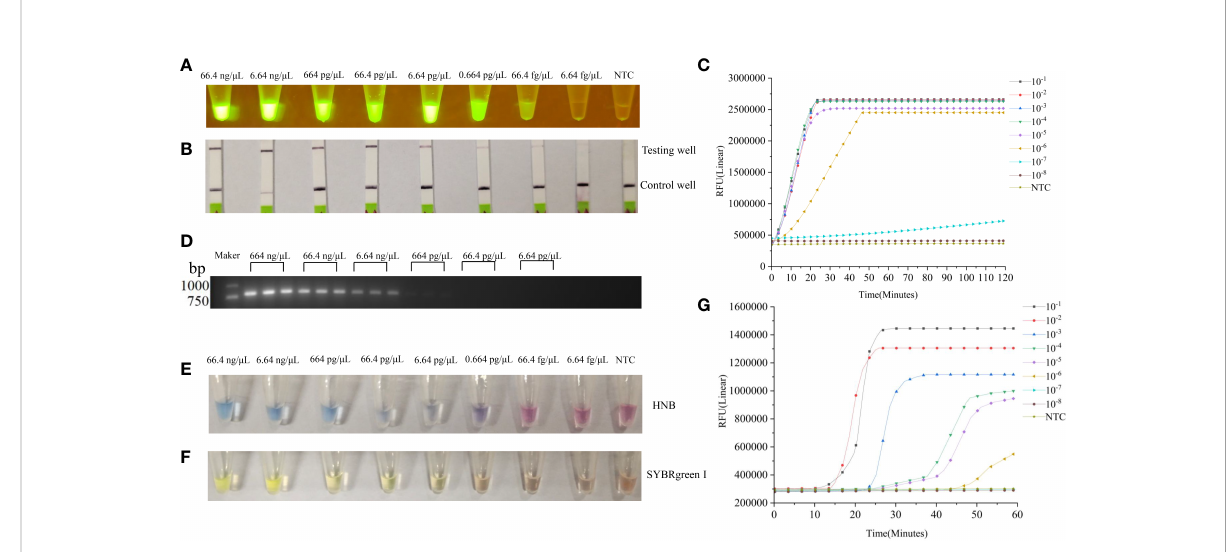
FIGURE 5 (A) Sensitivity of the LAMP-CRISPR/Cas12a assay for B xylophilus detection. Puri fi ed B xylophilus genomic DNA was diluted by 10 − 1 , 10 − 2 , 10 − 3 , 10 − 4 , 10 − 5 , 10 − 6 , 10 − 7 , and 10 − 8 to give DNA concentrations of 66.4 ng/µL, 6.64 ng/µL, 664 pg/µL, 66.4 pg/µL, 6.64 pg/µL, 0.664 pg/µL, 66.4 fg/ µL, and 6.64 fg/µL. Different concentrations of DNA were detected by LAMP-CRISPR/Cas12a assay and visualized by blue light. (B) Results of the LAMP-CRISPR/Cas12a assay visualized by lateral fl ow biosensor. (C) Real-time fl uorescence pro fi les of DNA at different concentrations in LAMP- CRISPR/Cas12a assay. (D) Sensitivity of the PCR assay for B xylophilus detection. The image shows ampli fi cation bands targeting the SYG-2 gene. Lanes 1 – 6 lanes are B xylophilus genomic DNA dilutions 664 ng/ m L, 66.4 ng/µL, 6.64 ng/µL, 664 pg/µL, 66.4 pg/µL, and 6.64 pg/µL (3 replicates per concentration). (E, F) Different concentrations of DNA were detected by traditional LAMP and visualized by HNB and SYBRgreenI. (G) Real-time fl uorescence curves of DNA with different concentrations in LAMP.